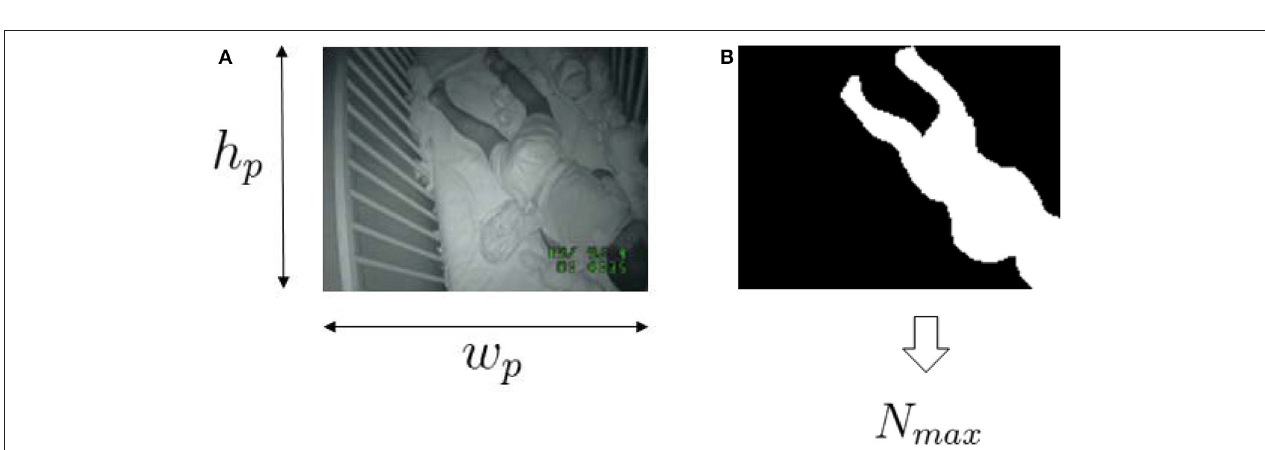
FIGURE 1 | Block diagram of automated videosomnography (auto-VSG) processing system. *Preprocessing block includes Image Resizing, Red Green Blue (RGB) to Gray Scale Conversion and Histogram Equalization. w p and h p are width and height of the resized image used in the preprocessing block, τ s is duration of each time segment (epoch) [60s], h is the number of frames used to obtain the Background model B , T is a threshold for each pixel to determine whether there is a movement or not and n m is number of moved pixels in the current frame.